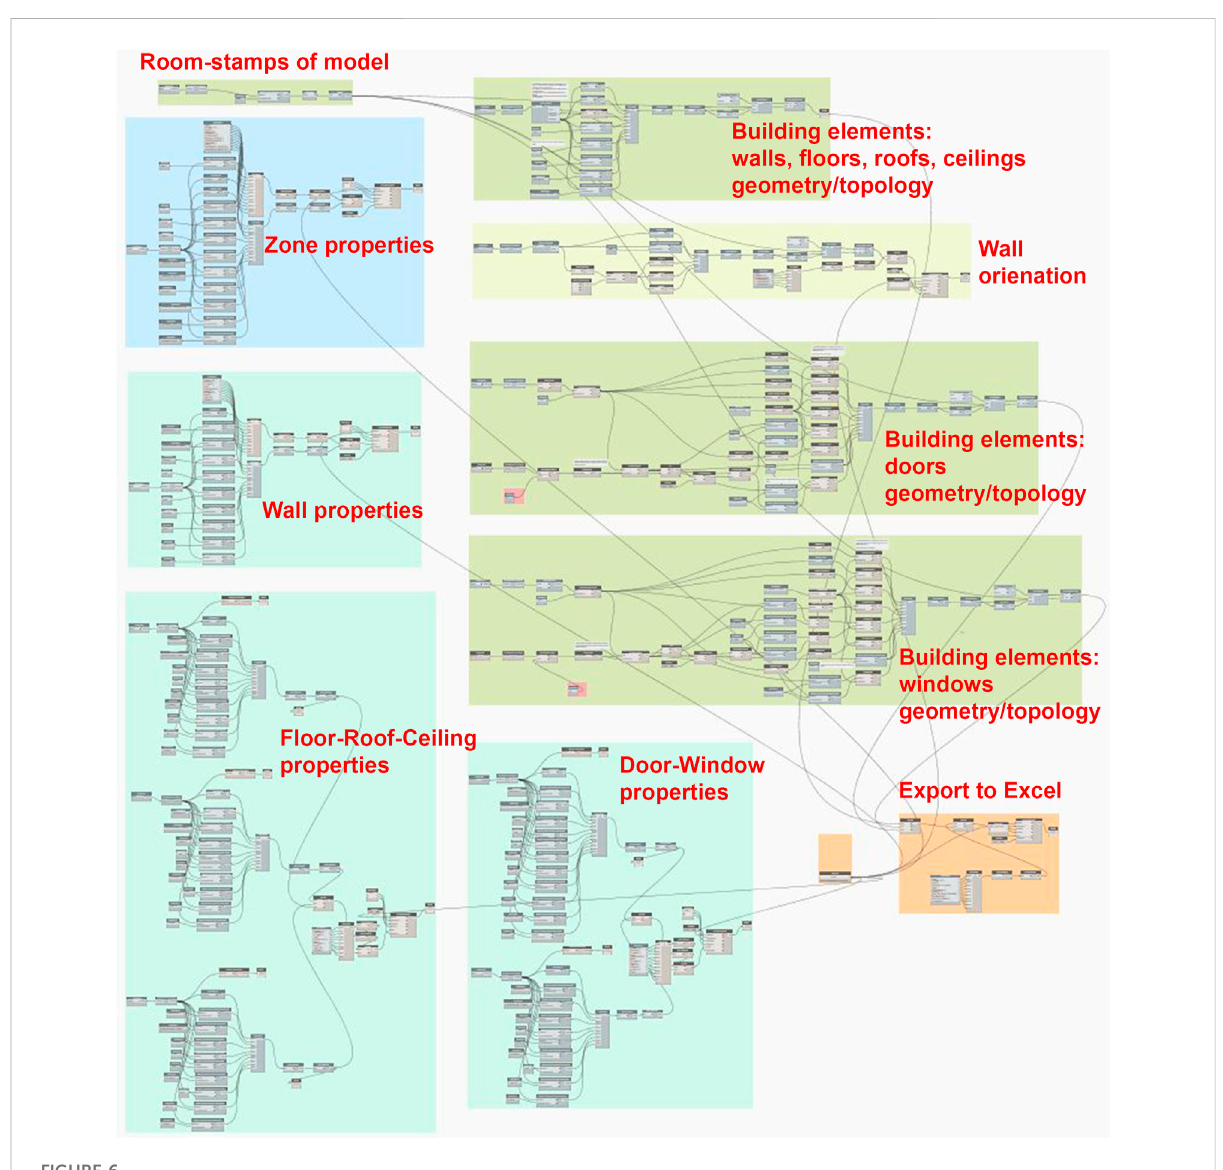
FIGURE 6 Overview of the Dynamo algorithm.